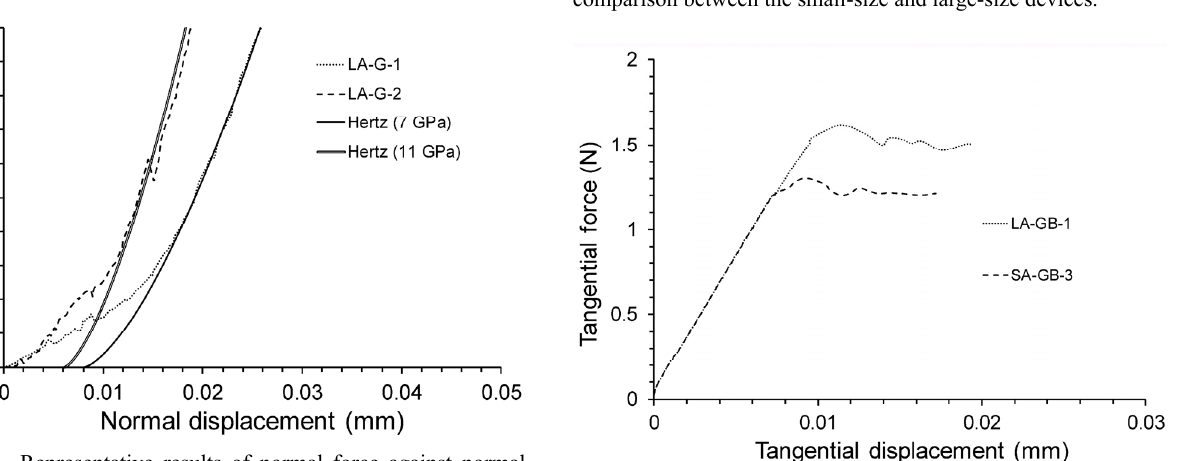
Fig. 12 Representative results of normal force against normal displacement on crushed granitic granules and the corresponding Hertzian fitting .